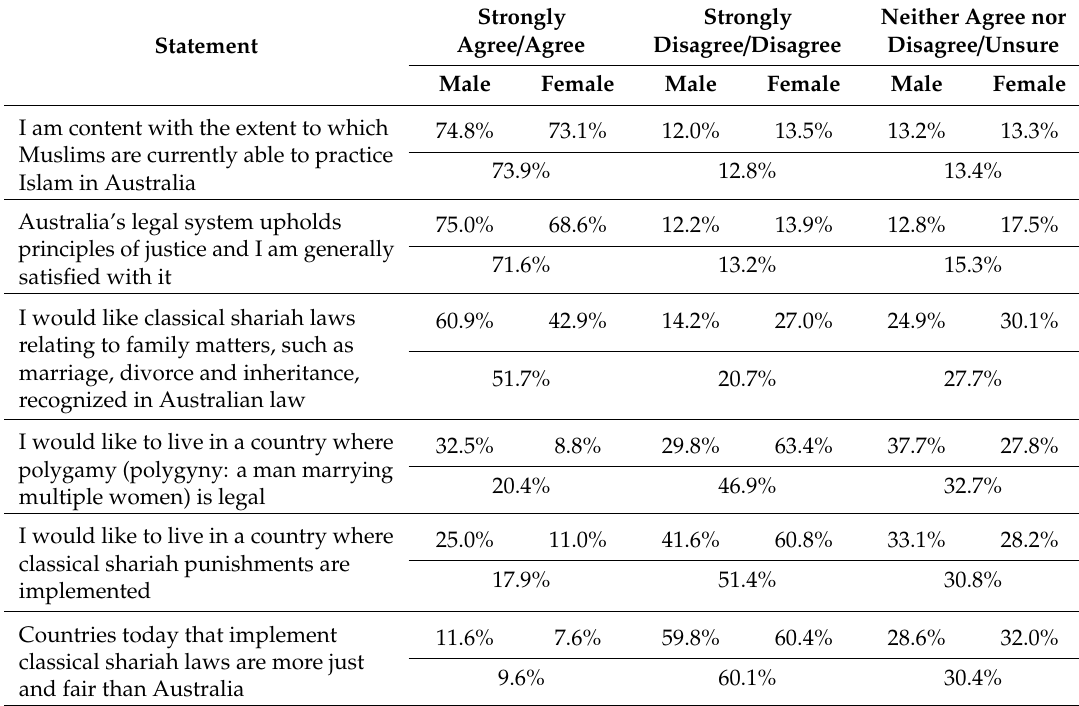
Table 6. Shariah and society by